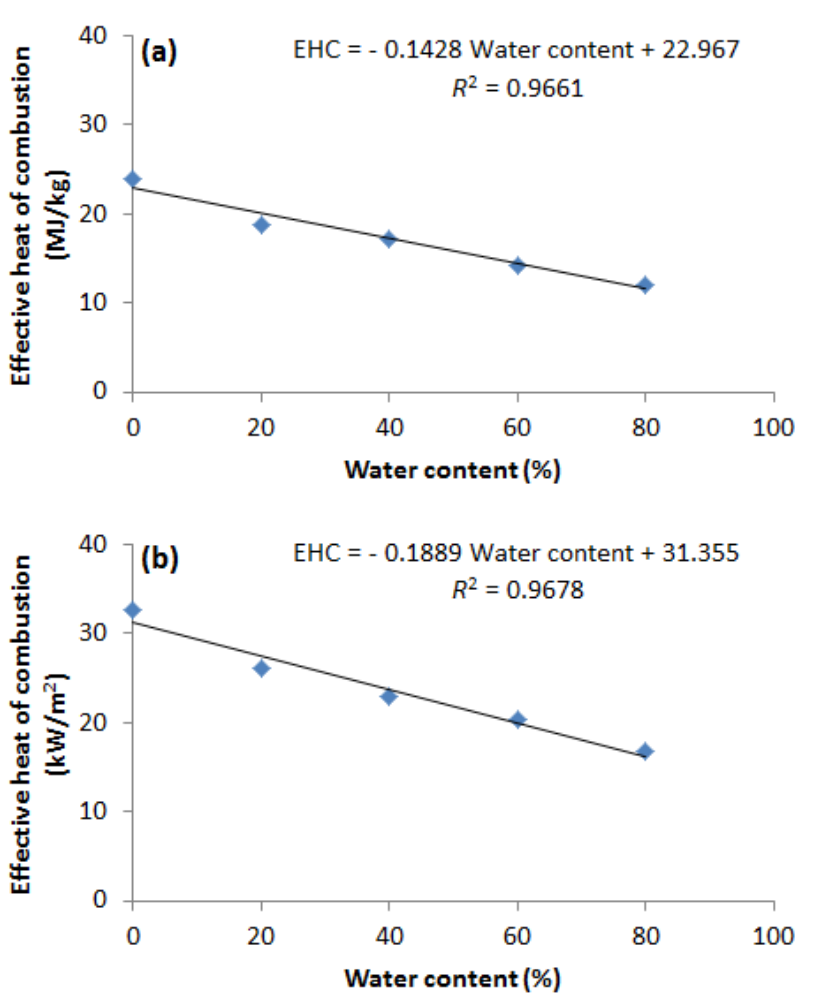
Figure 5. Dependency of the effective heat of combustion of investigated fuels on the water content: ( a ) Dependency of the effective heat of combustion of methanol on the water content; ( b ) Dependency of the effective heat of combustion of ethanol on the water content (EHC: effective heat of combustion).